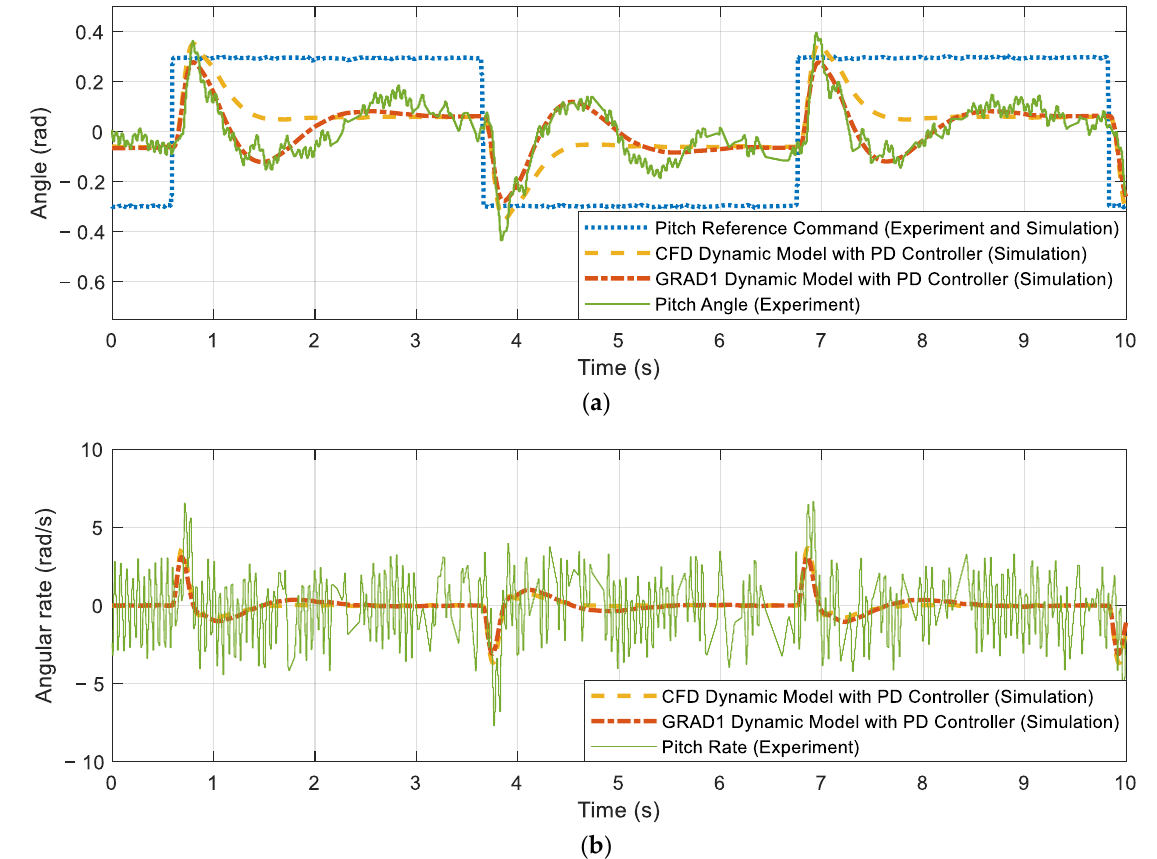
Figure 9. Experimental flight data and simulation results of the GRAD1 dynamic model using a PD feedback controller: ( a ) pitch angle, and ( b ) pitch rate for the provided reference command of the square signal with long period and constant frequency.